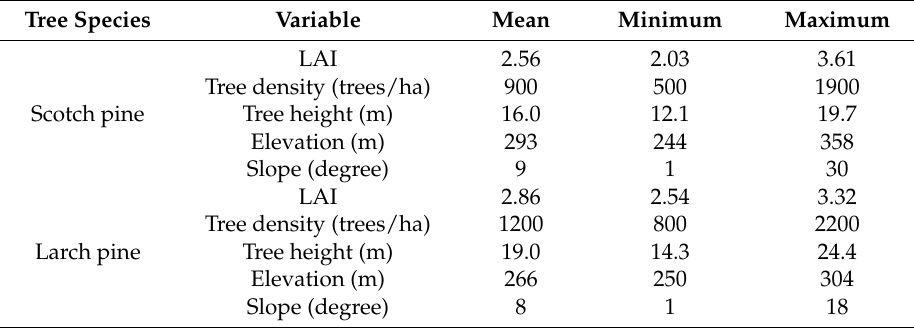
Table1. Descriptive statistics of the field sample plots (plot number = 63). Table 1. Descriptive statistics of the field sample plots (plot number =